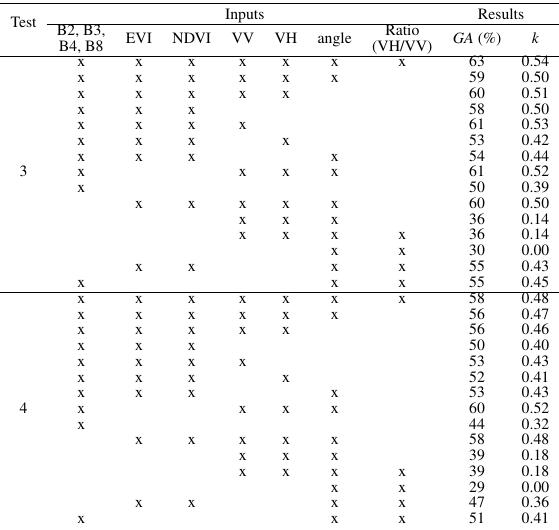
Table 4. k index for RF and SVM classifiers applied to different Table 6. Combination of bands and indices used for the dates and using combinations of bands and/or indices in classification with SVM in Scenario 3, along with GA and k . Scenario 2